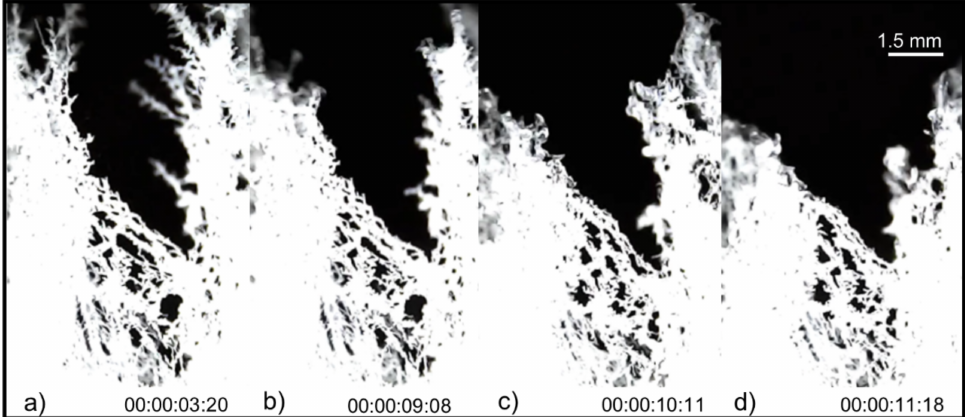
Figure 10. Pictures of frames from 3 s 20 to 11 s 18, showing dendrite transformation into packed ice in the absence of the applied field. Dendrites on the top of the porous network follow the potential gradient alignment in ( a ) but collapse under zero electric field, from ( b – d ).